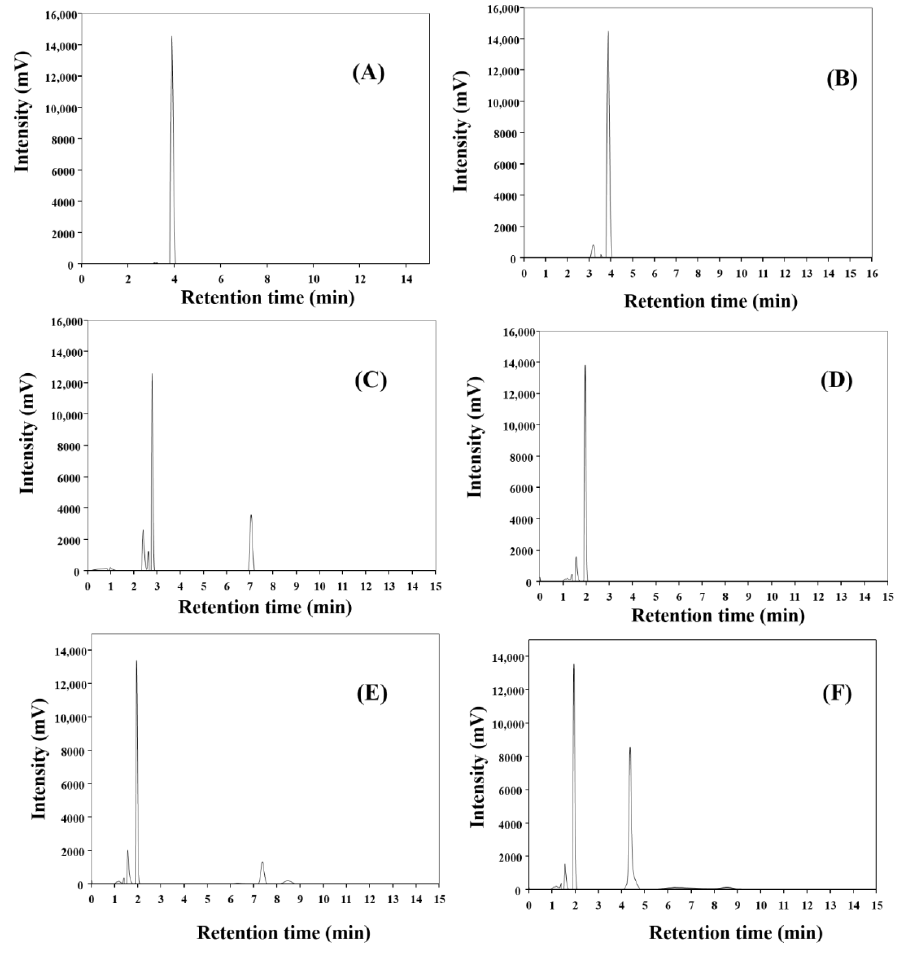
Figure 11. HPLC analysis of the ampicillin degradation by HNTs-Fe 3 O 4 -CTs-S-S-Laccase ( A )